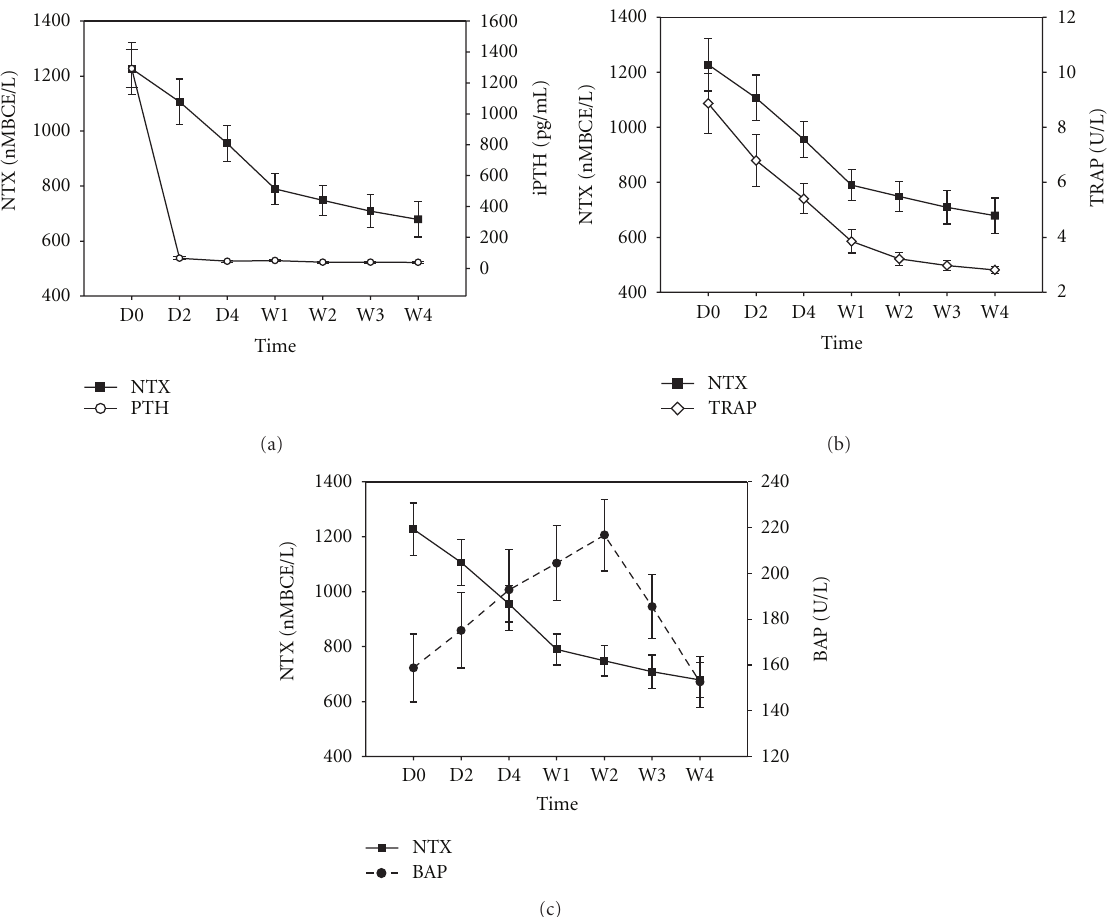
Figure 1: Comparison of serum values for the cross-linked N-telopeptide of type I collagen (NTX) with those for other bone markers before and at various times after parathyroidectomy (PTX) for secondary hyperparathyroidism. (a) NTX and intact parathyroid hormone (iPTH); (b) NTX and tartrate-resistant acid phosphatase 5b (TRAP); (c) NTX and bone alkaline phosphatase (BAP). D0: before PTX; D2, D4, W1, W2, and W4: 1 day, 3 days, 1 week, 2 weeks, and 4 weeks after PTX, respectively. Findings are presented as means ± SEM.